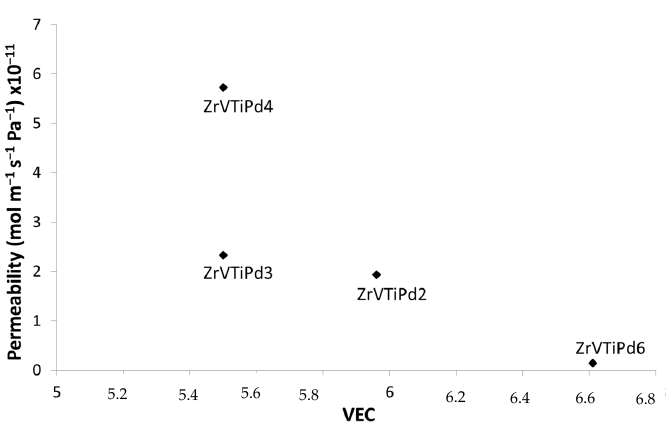
Figure 6. Hydrogen permeability measured at 350 °C for some membranes as a function of VEC.